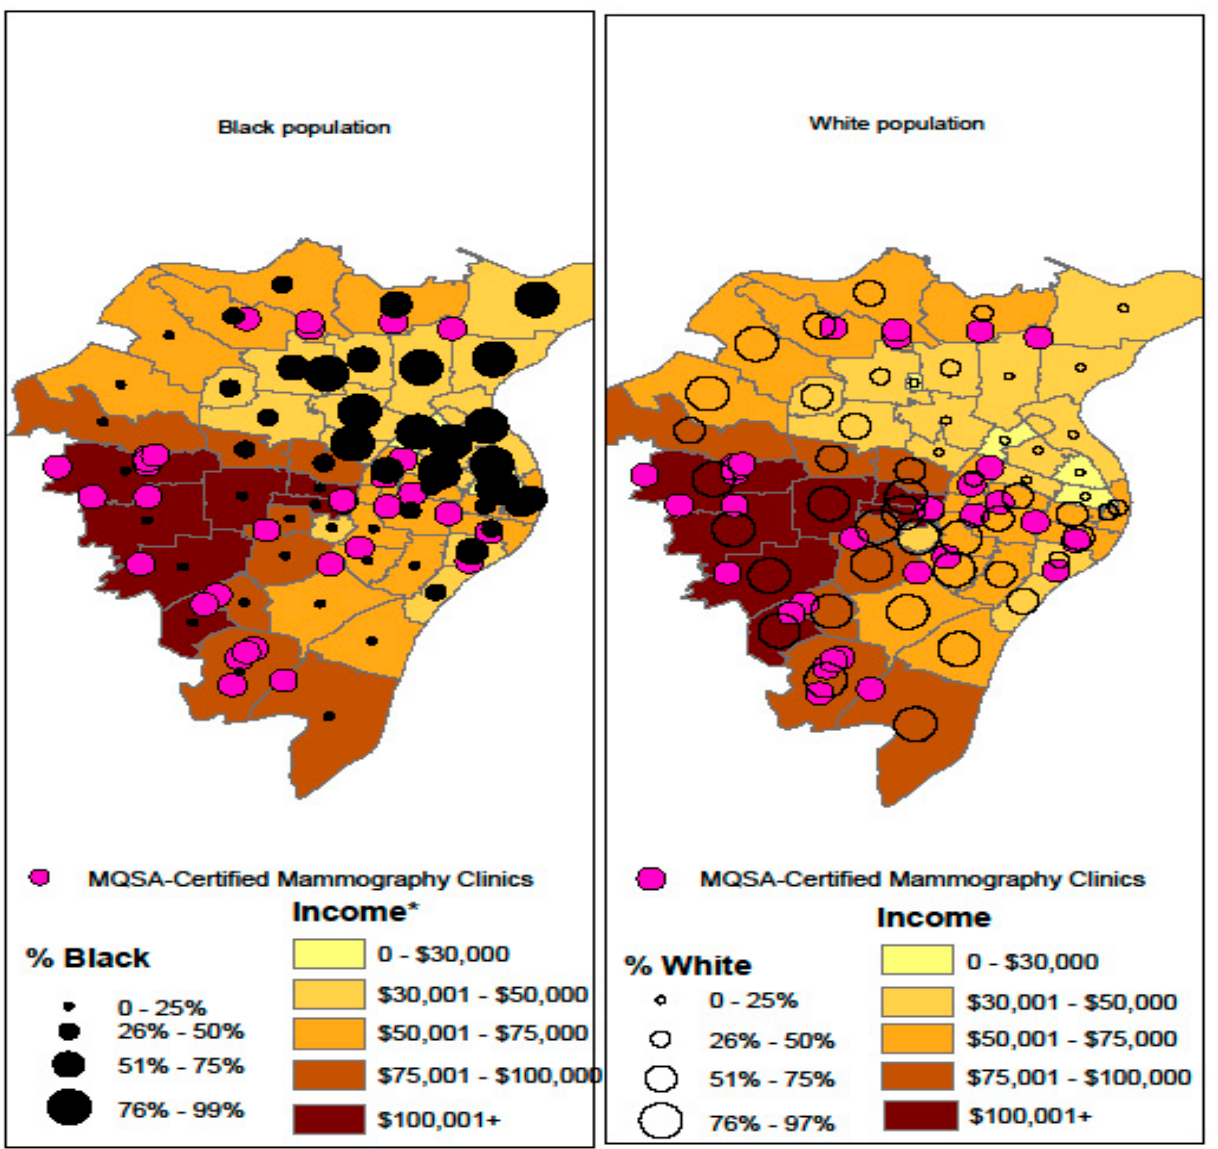
Figure A6. Percent Black vs. Percent White Population, MQSA-Certified Mammography Clinics, and Income by ZIP Code Tabulation Area in St. Louis, MO.